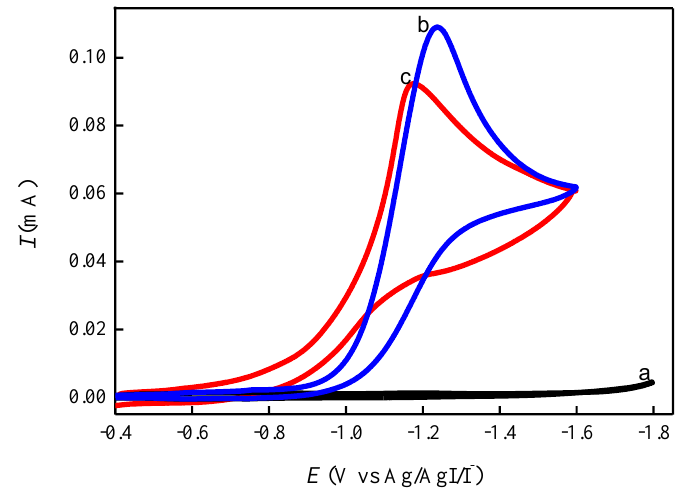
Figure 3. Cyclic voltammograms of 4 mM 1-phenylethyl chloride recorded at different cathodes in 0.1 M TEABF 4 –MeCN solution at a sweep rate of 0.1 V s − 1 at 18 ◦ C saturated with N 2 (a) background; (b) Ag disk; (c) Cu disk.